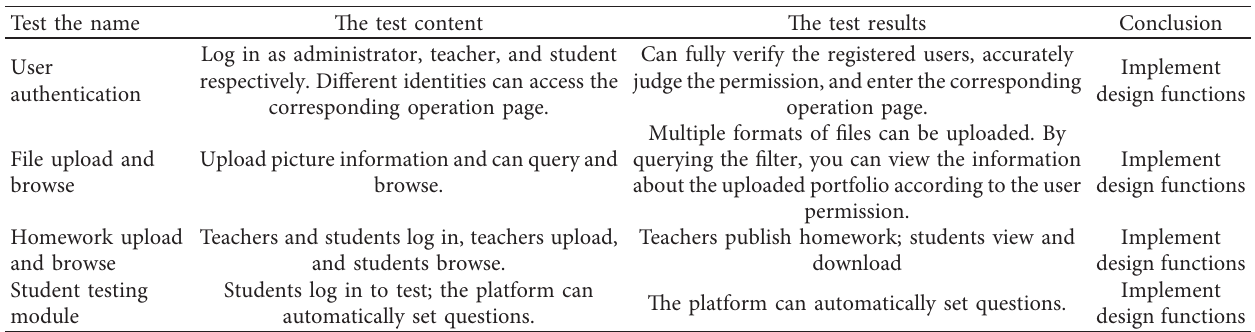
Table 4: Functional test results.